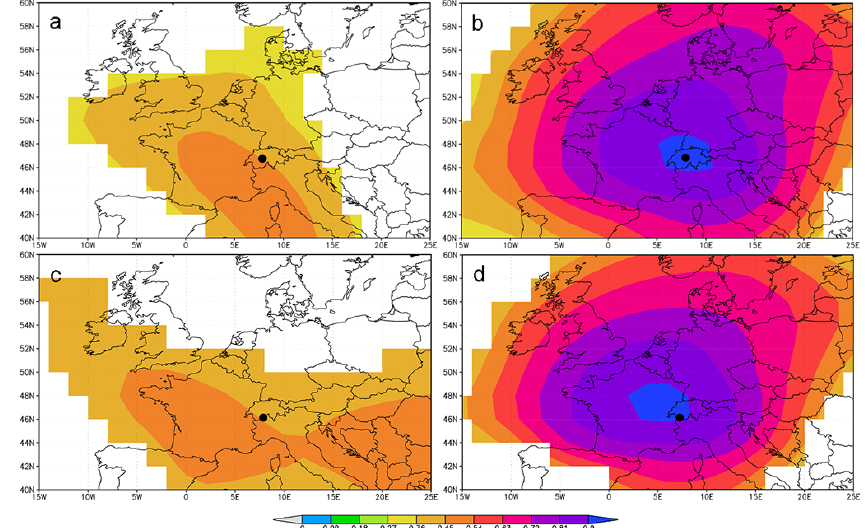
Figure 8. Spatial correlation maps of annual δ 18 O and temperature records with the Twentieth Century Reanalysis 700hPa temperature, for northern Alpine (upper panels, period 1961–2001) and southern Alpine sites (lower panels, period 1961–1993, 1968–1970 excluded). Correlation with (a) Fiescherhorn δ 18 O, (b) Jungfraujoch temperature, (c) Grenzgletscher δ 18 O (using the 20th century Reanalysis 700hPa precipitation-weighted temperature, Grand Saint Bernard precipitation utilized to weight the temperature), (d) Grand Saint Bernard temper- ature. Black dots indicate the location of the sites. Areas with correlation coefficients statistically significant at the 5% level are